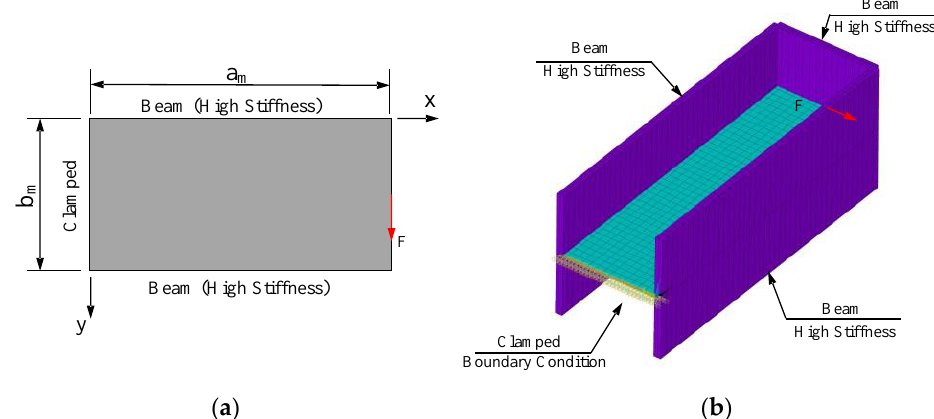
Figure 11. ( a ) Two-dimensional sketch and ( b ) three-dimensional representation of the geometry’s model and its boundary conditions for the case of shear buckling.